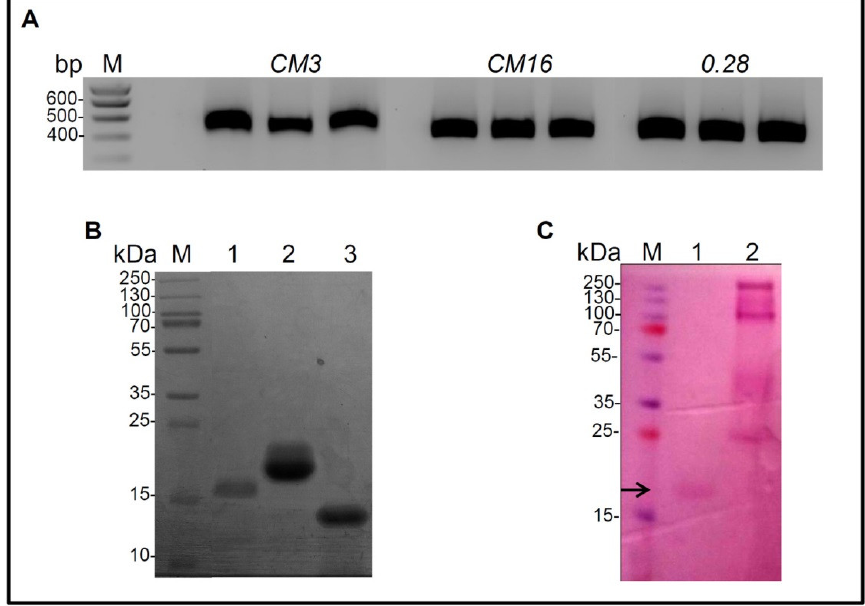
Figure 1. Production of recombinant CM3, CM16 and 0.28 allergens. ( A ) Agarose gel of the Reverse Transcription-PCR (RT-PCR) performed on cDNA of 28 days post anthesis Triticum aestivum cv. Bobwhite kernels by using specific primers for alpha-amylase/trypsin inhibitors (ATI) genes CM3 , CM16 and 0.28 . The three bands per sample correspond to technical replicates. M: marker. ( B ) Sodium dodecyl sulfate polyacrylamide gel electrophoresis (SDS-PAGE) analysis of purified ATI proteins heterologously expressed in Pichia pastoris after Ni-Nta purification and concentration steps. Samples: (M) Molecular mass marker; (1) Purified CM3; (2) Purified CM16; (3) Purified 0.28. ( C ) SDS-PAGE gel of purified CM16 protein subjected to periodic acid Schiff reagent staining for protein glycosylation detection. Samples: M) Molecular mass marker; (1) purified CM16 protein and (2) Positive control. The arrow indicates the band corresponding to CM16 .